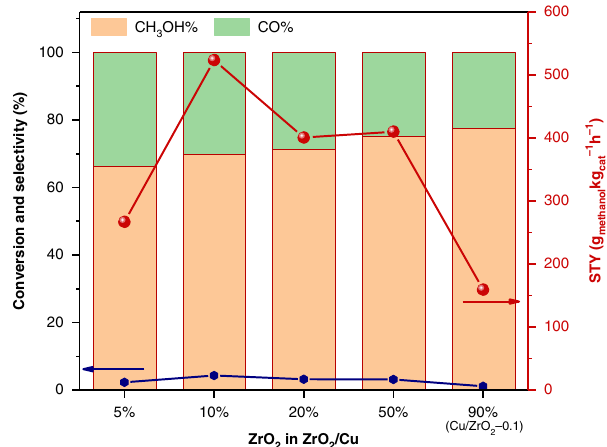
Fig. 2 The catalytic performance of ZrO 2 /Cu catalysts. CO 2 conversion (blue dotted line), product selectivity (methanol: orange bar, CO: green bar) and space time yield (STY) of methanol (red dotted line) as a function of the percentage of ZrO 2 in the ZrO 2 /Cu catalysts. Reaction conditions for the catalytic test: WHSV = 48,000 mL g − 1 h − 1 , T = 220 °C, CO 2 :H 2 = 1:3, P = 3.0 MPa. All the performance data were collected at a CO 2 conversion below